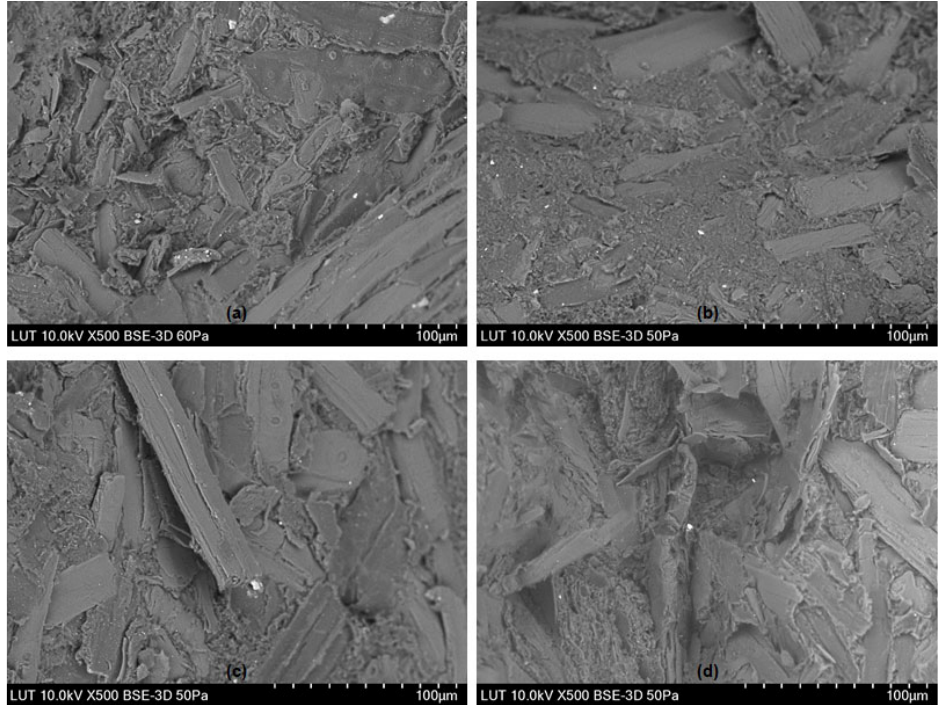
Figure 5. SEM images of wood ‐ fiber ‐ reinforced composites ( a ) R ‐ ABS/10WF; ( b ) R ‐ ABS/10WF ‐ S; ( c ) R ‐ ABS/20WF; and ( d ) R ‐ ABS/20WF ‐ S.